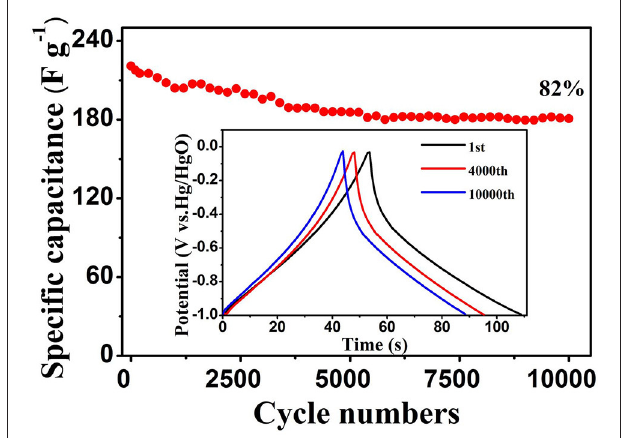
FIGURE 6 | Cycling stability of the WO 3 · 2H 2 O/BC electrode at 4A g − 1 ; the inset shows GCD curves at different cycles.